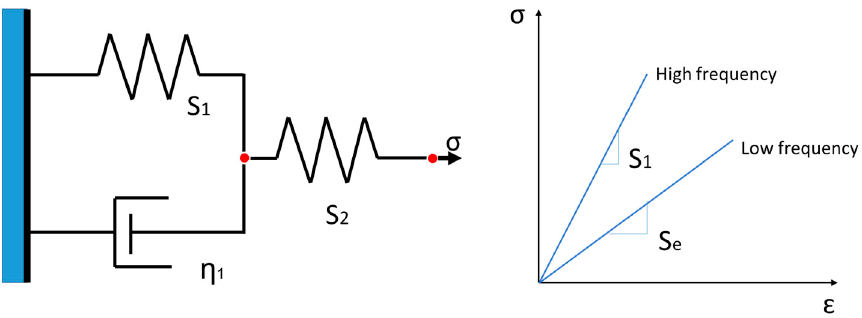
Figure 2. The transient-creep-plus-elastic model. Image adapted from Ref. [32].